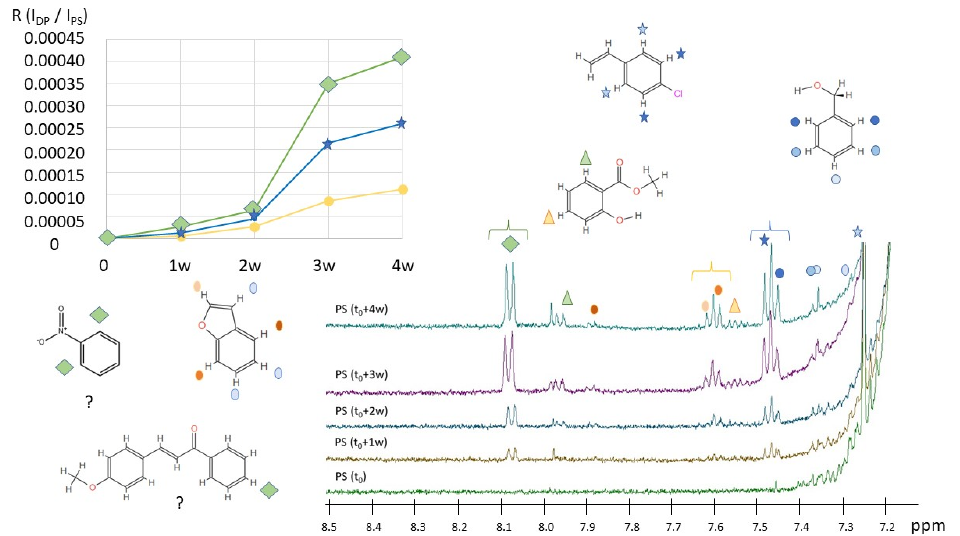
Figure 8. Enlargement of the 1 H NMR spectra of pristine PS (t 0 ) and PS after 1 w, 2 w, 3 w, and 4 w of degradation, from 7.2 to 8.5 ppm. Main 1 H NMR aromatic signals have been assigned to compounds, whose molecular structure is shown. Hypothetical compounds are also reported as described in the text. The correspondence between each signal and the proton/protons on the molecular sketches is put in evidence through colored symbols. On the top left, the ratio R between the integral of the aromatic signals of PS (I PS ) and the integral of the signals of degradation products (I DP ), during the degradation time, from 0 (t 0 ) to 4 weeks (t 0 + 4 w) for three more significant signals, as indicated by the colored braces on top of the 1 H NMR spectra.